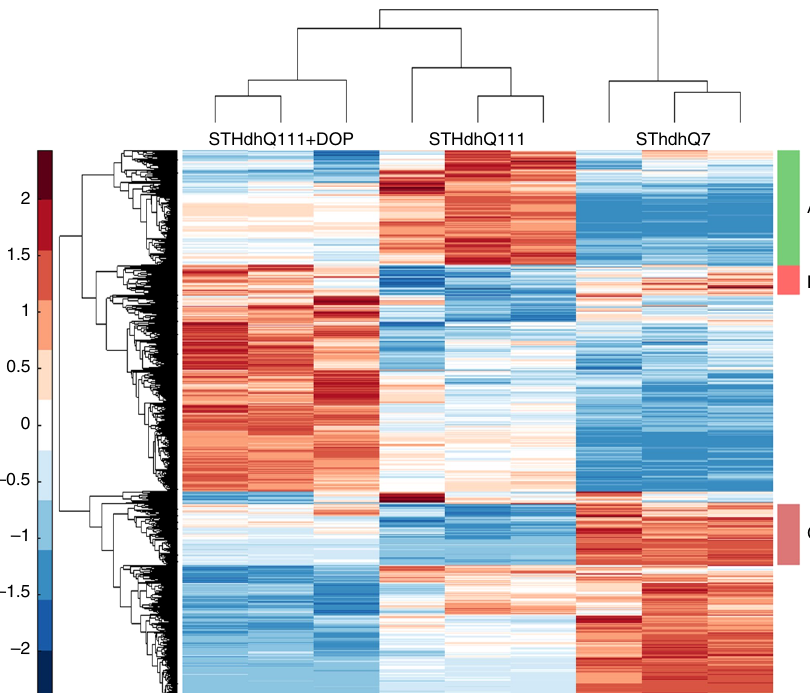
Fig. 9 Differentially expressed genes after treatment with DOP. Hierarchical clustering of gene expression data from differentially expressed genes in STHdh Q7, STHdh Q111, and STHdh Q111 cells after treatment with 4 mM DOP. Cluster A represents the genes whose expression levels are downregulated after DOP treatment, and are closer to STHdh Q7 expression levels. Clusters B and C show the genes whose expression levels are increased after treatment with 4 mM DOP and are corrected toward STHdh Q7 expression